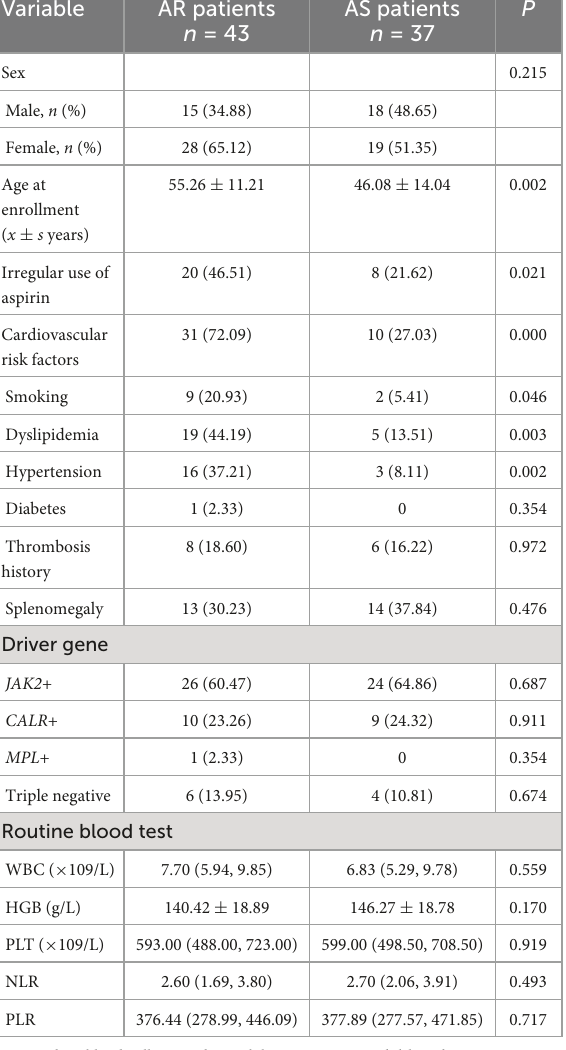
3 cases of AR and 1 case of AS) ET patients exceeded the normal upper limit, while other indexes (D-D, PT, PTA, INR, APTT, TT, FDP, and AT-III) did not. On TEG, 7.5% (6/80, 5 cases of AR and 1 case of AS) of patients had enhanced